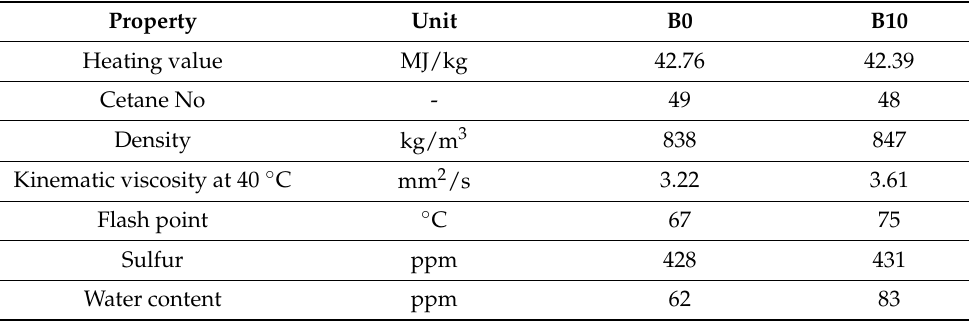
Table 3. Comparison of biodiesel blend and diesel fuel properties.